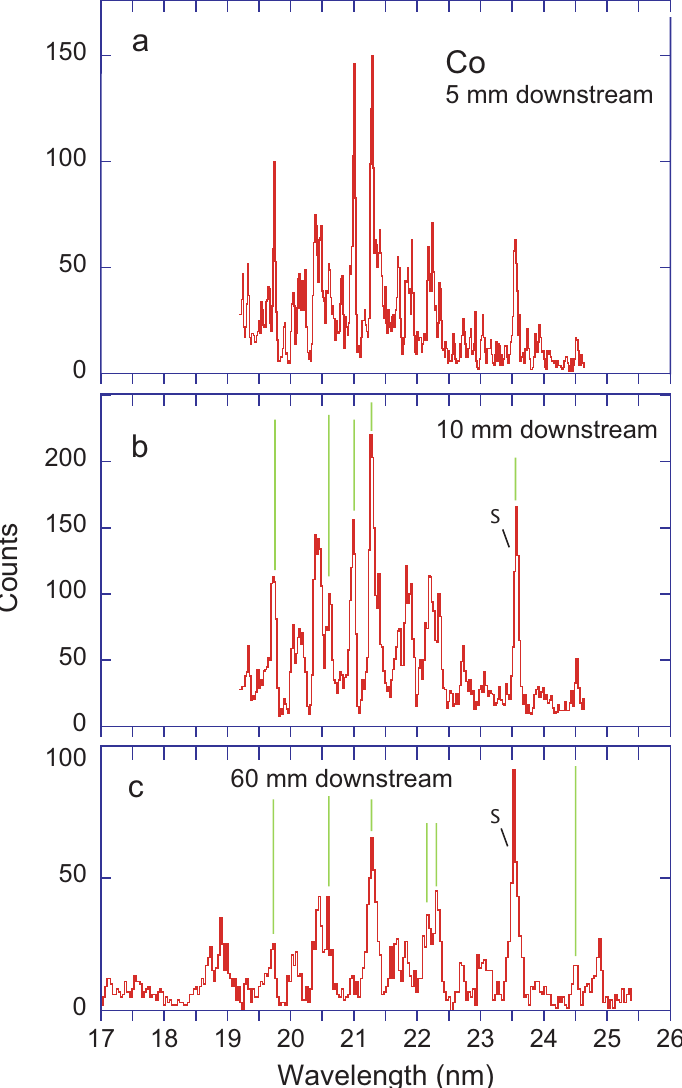
Figure 24. Beam-foil spectra of Co at an ion beam energy of 8MeV. Observation ( a ) with a delay after excitation of 1 ns, line width (FWHM) 0.045 nm; ( b ) delay of 2 ns, line width (FWHM) 0.075 nm; ( c ) 60mm downstream of the foil (delay 12ns), line width (FWHM) 0.09nm. Vertical green lines indicate possible wavelength reference transfer lines. The spectral feature associated with the Co XII (S-like) ground state intercombination transition line group is